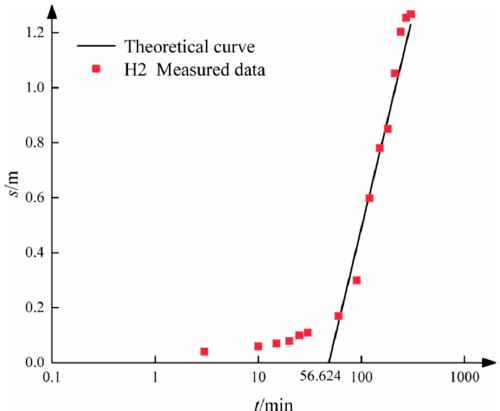
Figure 6. Comparison of the theoretical drawdown obtained by the newly estimated parameter and the measured field data for observation well H2.